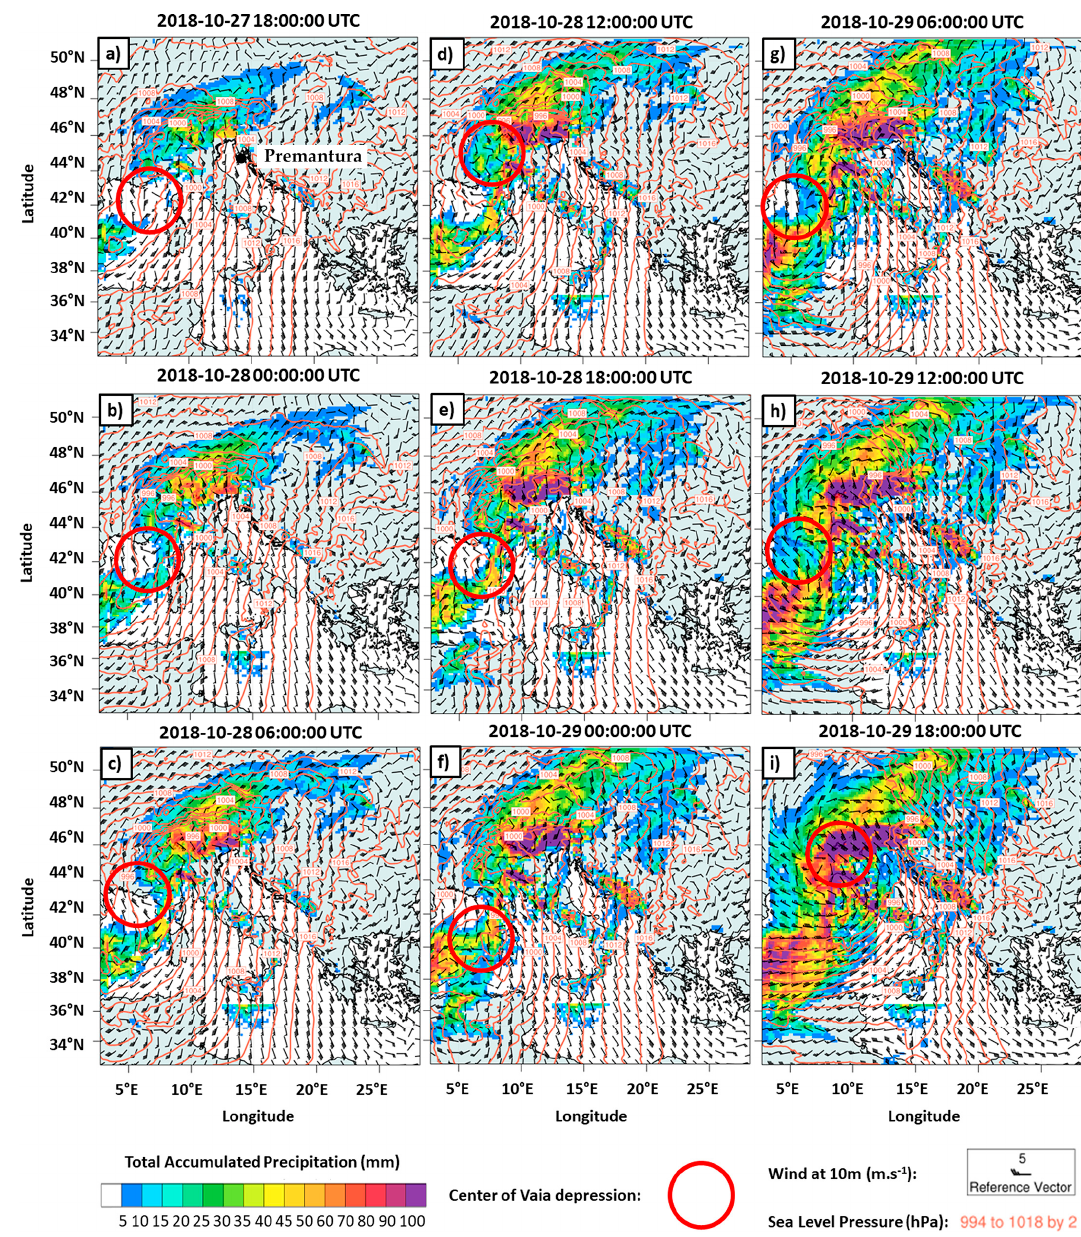
Figure 2. Evolution of the accumulated rain, the sea level pressur, and the winds (in chronological order from panel ( a – i )) during storm Vaia using the numerical results obtained with the WRF-15km model from the AdriSC modeling suite. The center of the depression is represented with a red circle which highlights the track of the storm.